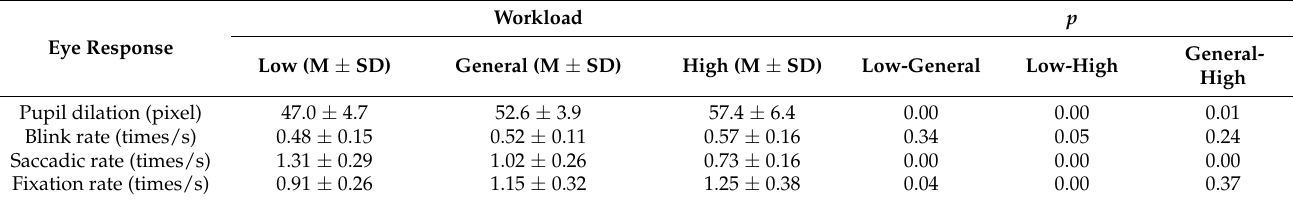
Table 6. The t -test of eye response between different